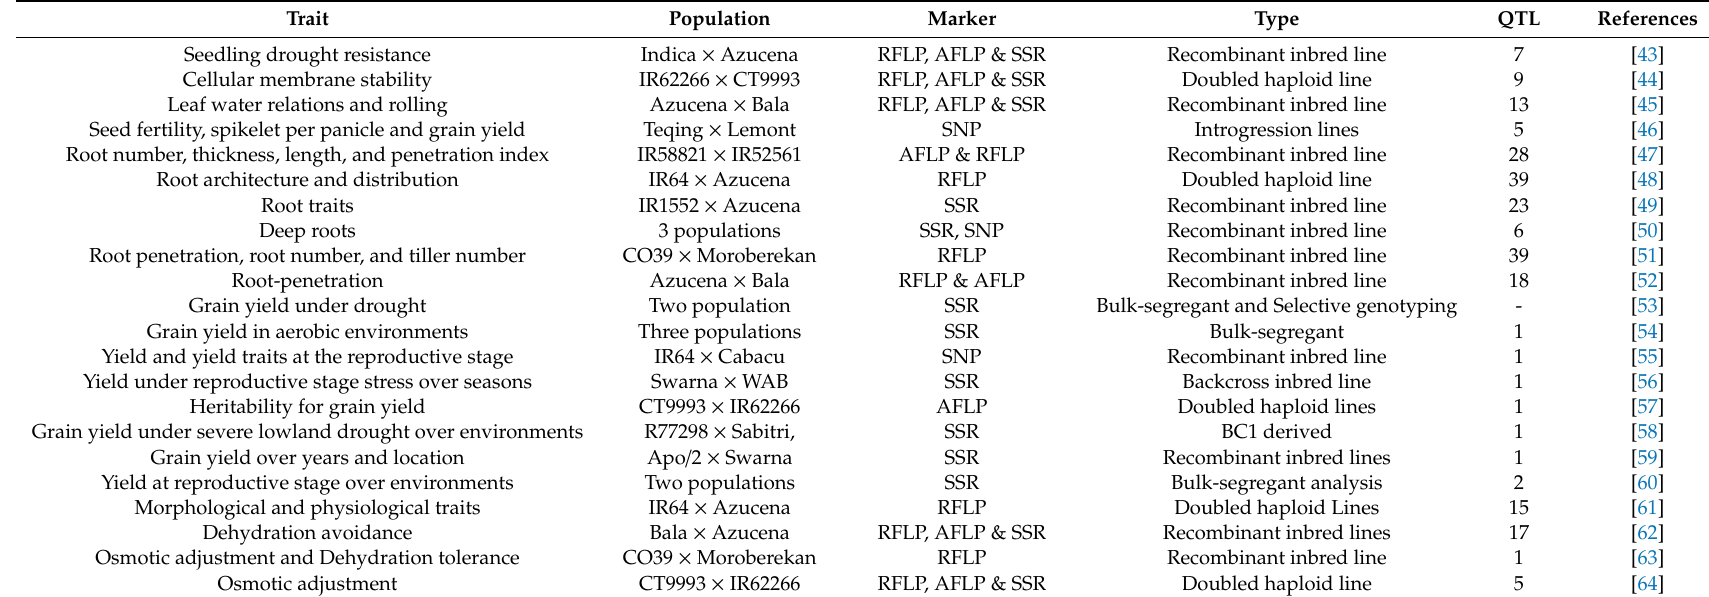
Table 1. QTL for shoot and root responses under drought stress